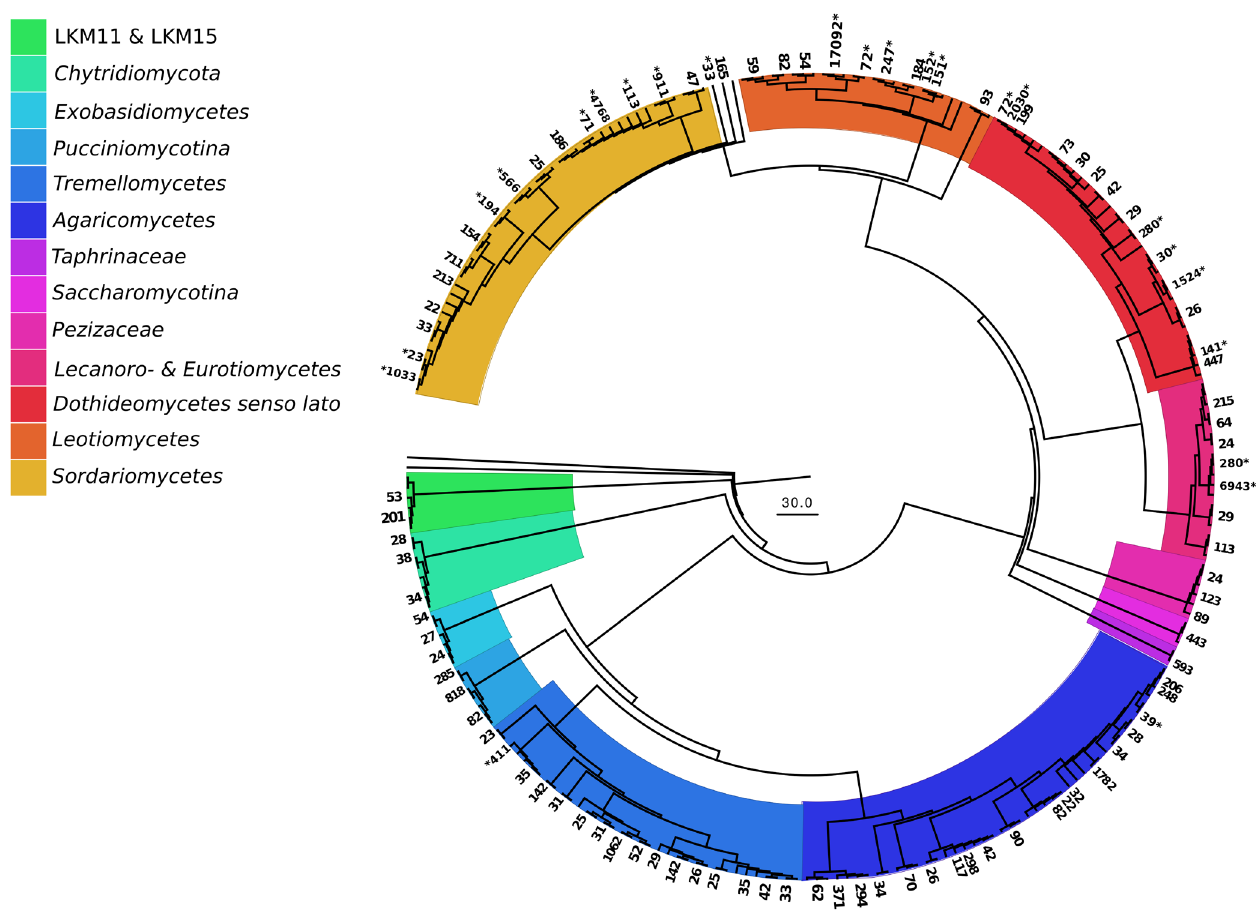
Figure 3. Phylogenetic tree based on the SILVA reference database and the top 100 OTUs retrieved from particle DNA (added with parsimony). Numbers of retrieved sequences per OTU are written at the outer rim; asterisks mark taxa that were also recovered on leaf litter. Branches without numbers are reference sequences (SILVA) (based on Dataset 3).